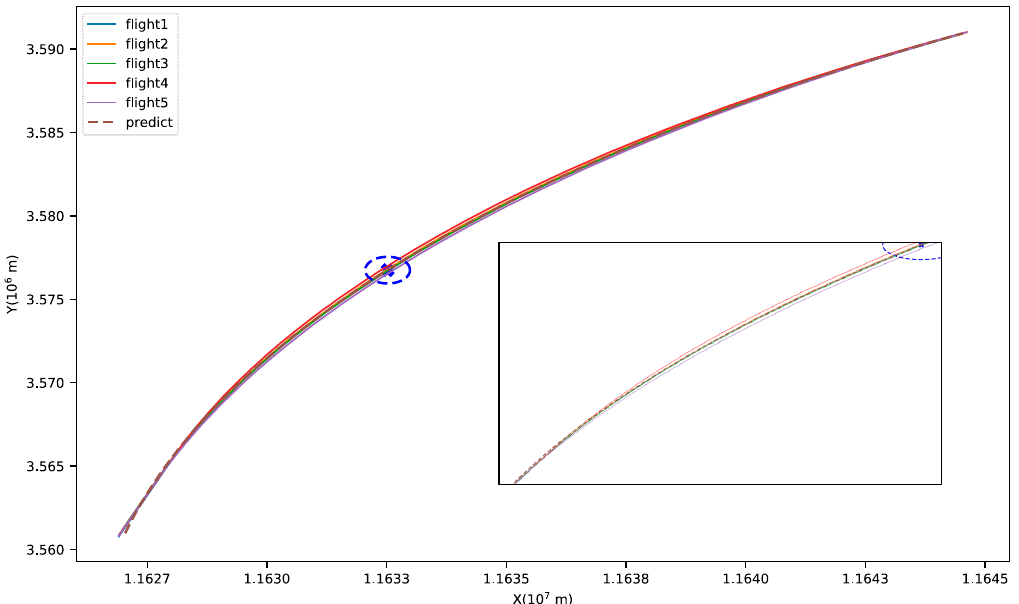
Figure 10. Predicted trajectory for the flight turn (the subfigure is the partial enlargement of the predicted trajectory).